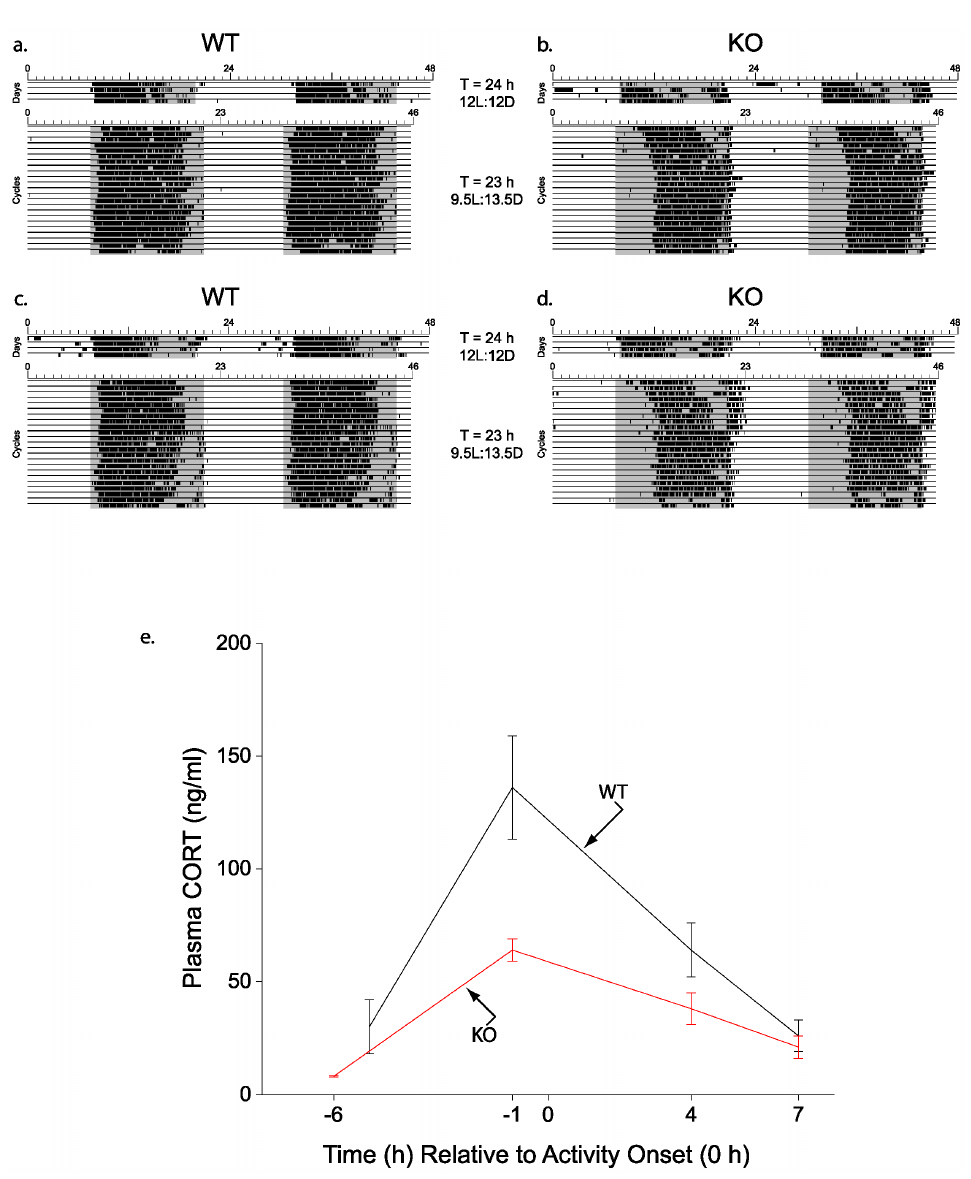
Figure 1. Activity and corticosterone levels of wild type and 5-HT 1B knockout mice in 9.5L:13.5D conditions. Wheel-running activity records double-plotted in the standard manner, with each day’s activity plotted beneath and after the previous day’s activity (shaded region represents dark). Examples of activity of wild type (WT; a & c) and 5-HT 1B knockout (KO; b & d) mice transferred from 12L:12D (T=24 h) to 9.5L:13.5D (T=23 h) conditions. Animals re-entrained to the short-day 23 h cycle although wheel-running activity onsets, relative to light offset, were significantly more delayed in KO animals compared to WT animals in the 9.5L:13.5 D conditions (p , 0.001). (e) Plasma corticosterone (CORT) levels exhibited a diurnal rhythm with peak values observed one hour before activity onset ( 2 1 h time point); the peak plasma CORT value for KO animals was significantly less than peak plasma CORT value of WT mice (p , 0.01). 9–13 plasma samples/time point. doi:10.1371/journal.pone.0111944.g001 (4.7 6 0.06 h, range 4.5–5.1 h, n= 10) (p , 0.0001). These data onsets occurred. CORT levels were determined at 6 h (or 5 h) and suggest that 5-HT 1B KO mice generate a diurnal rhythm of 1 h before activity onset ( 2 6 h, 2 5 h, and 2 1 h time points), and at 4 h and 7 h after activity onset (4 h, 7 h time points). The peak plasma CORT synchronized with the concurrently assessed plasma CORT value for both the WT and 5-HT 1B KO mice was activity rhythm, similar to WT mice, despite the altered phase relationship of the activity rhythm to the L:D cycle. However, the observed at the 2 1 h time point although the peak CORT value amplitude of the diurnal rhythm of plasma CORT of 5-HT 1B KO for KO mice was significantly less than that of the WT mice under the 9.5L:13.5D conditions (KO, 64 6 5 ng/ml, n= 10, vs WT, mice with a highly delayed phase angle of entrainment is 136 6 23 ng/ml, n =9; p , 0.01) (Fig. 1e). The Y of the subset of significantly attenuated and is reduced < 50% compared to WT animals sampled at the 2 1 h time point was 0.6 6 0.04 h controls. An alternative interpretation of the data is that 5-HT 1B (range 0.4–0.75 h, n = 9), significantly different than the Y of the KO mice are simply unable to generate a normal amplitude in the subset of KO animals sampled at the 2 1 h time point diurnal CORT rhythm under any conditions.